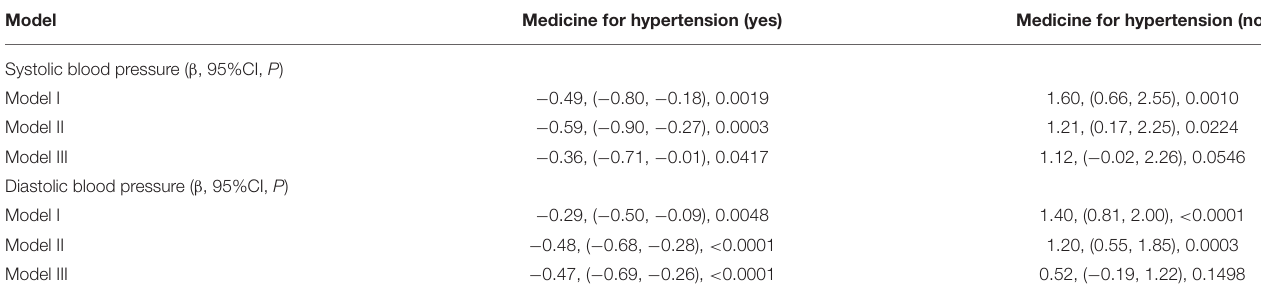
TABLE 2 | Result of multiple linear regression analysis between uric acid and blood pressure in hypertension treatment group and non-treatment group.